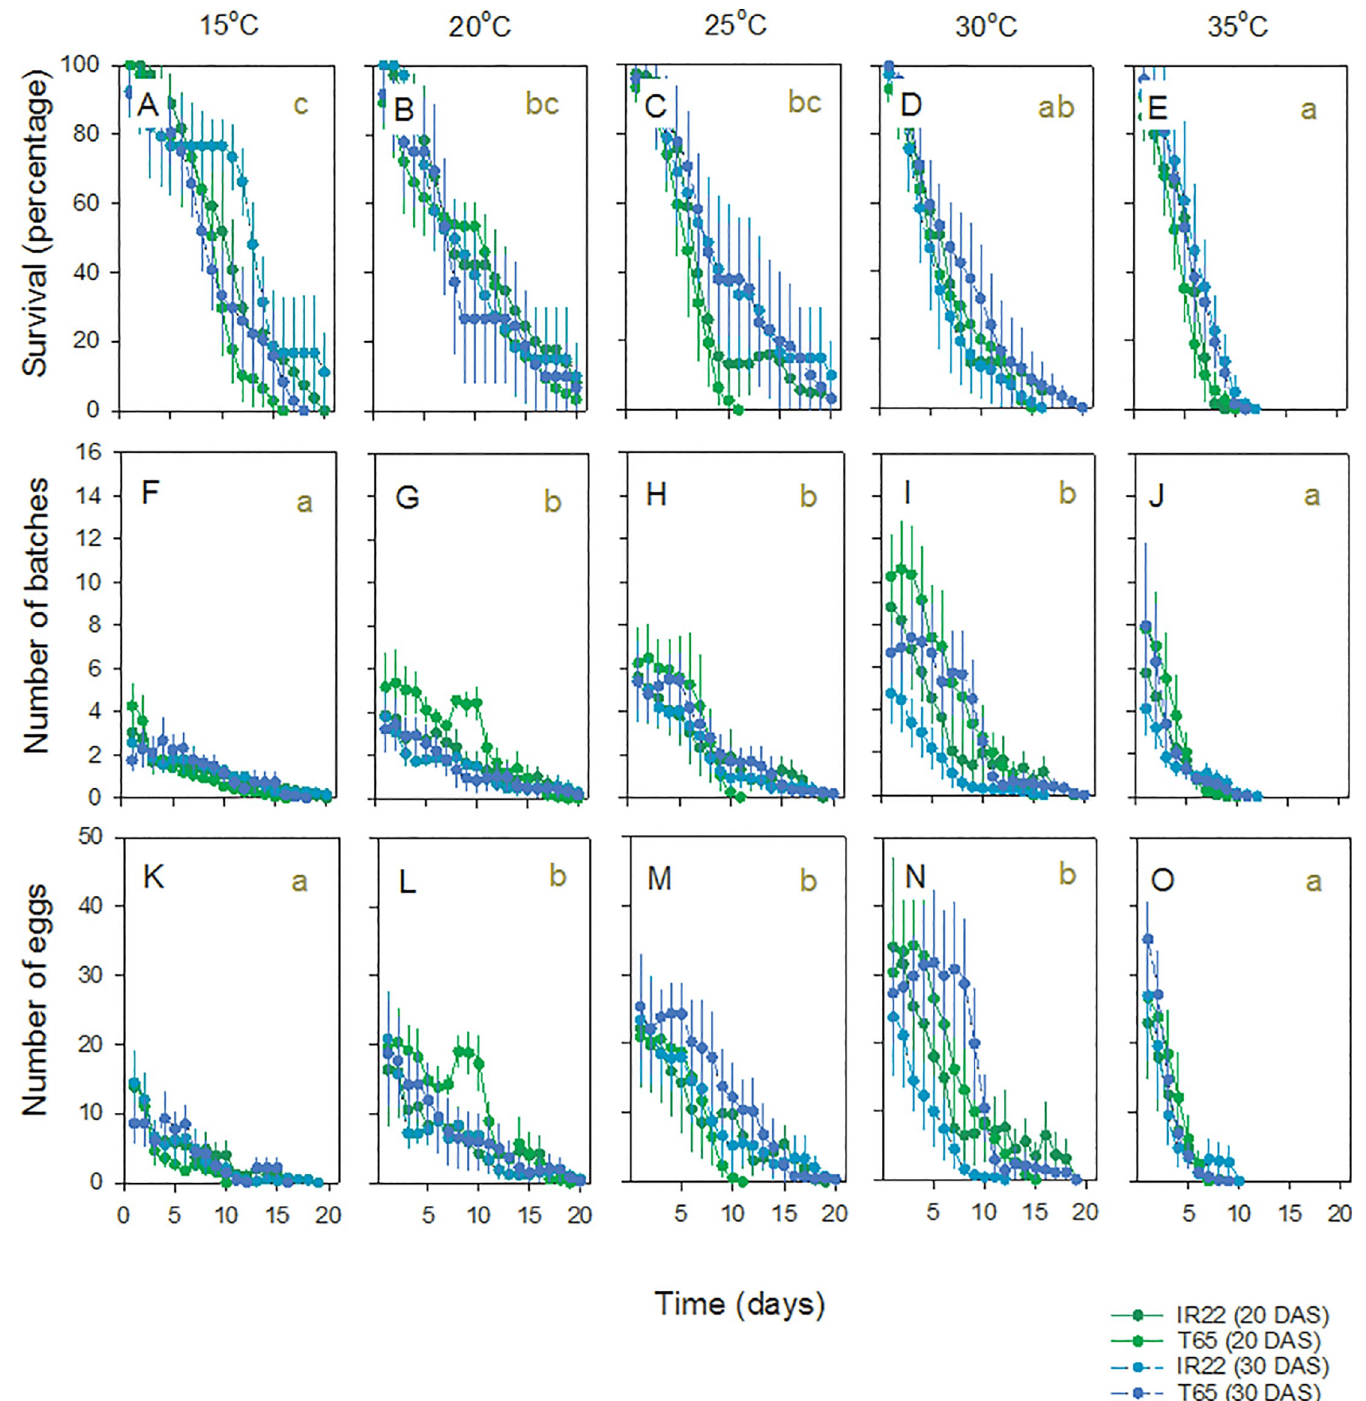
Fig 2. Effects of temperature on adult survival and egg-laying by BPH on indica (IR22) and japonica (T65) rice varieties. Infestations were initiated at 20 and 30 DAS; younger plants are indicated by green symbols and lines. Bioassays were conducted at 15˚C (A,F,K), 20˚C (B,G,L), 25˚C (C,H,M), 30˚C (D,I,N) and 35˚C (E,J,O). Bioassays conducted at 40˚C are not shown (see text). Results for adult survival during the experiment (A-E), the total numbers of batches produced (F-J), and the total number of eggs deposited (K-O) are presented. Standard errors are indicated (N = 4). Lowercase letters indicate homogenous temperature groups for each parameter (Tukey: P � 0.05) based on repeated measure GLM. See also Table